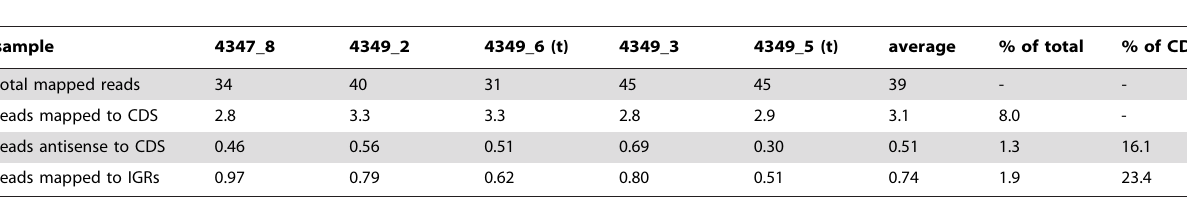
Table 1. RNA sequencing profiles for exponential phase cultures of M. tuberculosis.